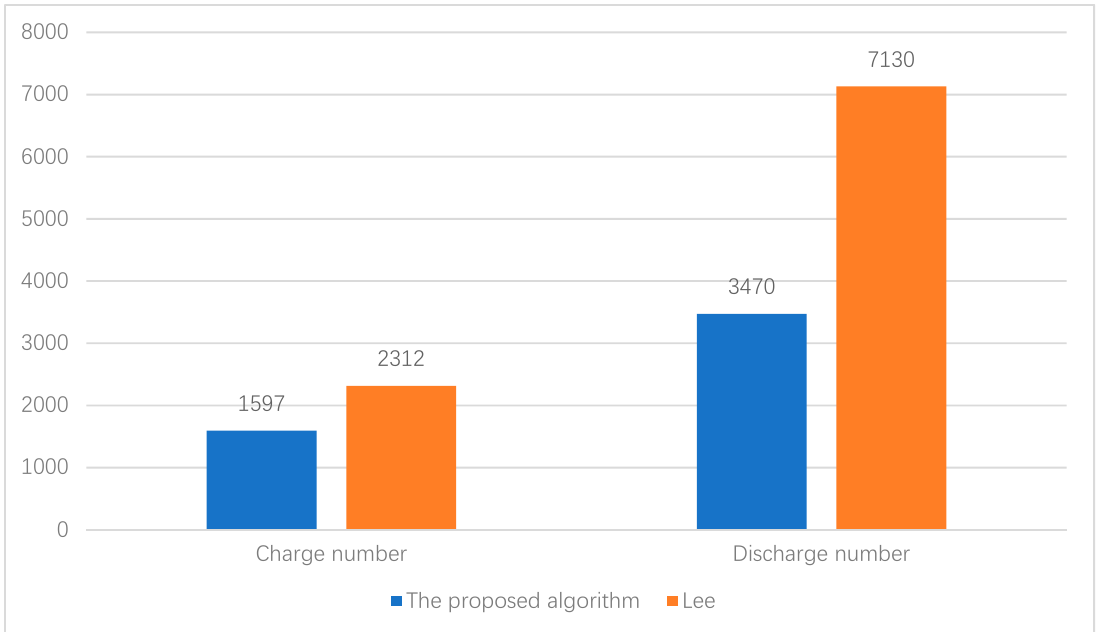
Figure 13. Comparison of charge and discharge times. Appl. Sci. 2019 , 9 , x FOR PEER REVIEW